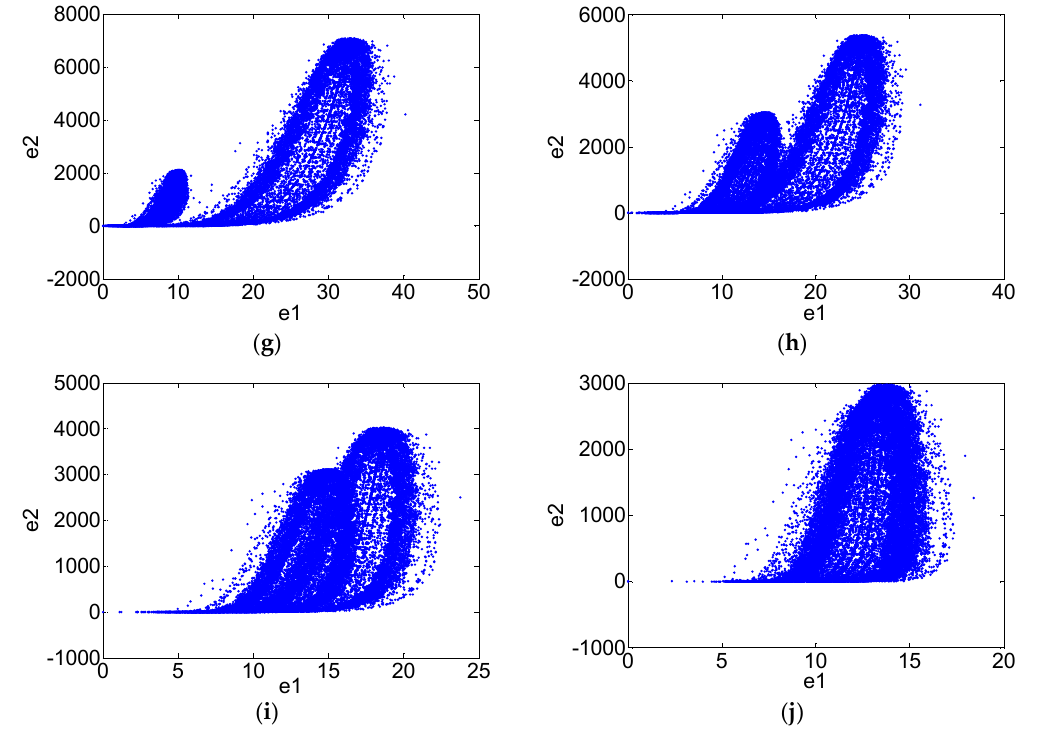
Figure 10. Chaotic dynamic error path showing islanding. ( a ) α = 1 ( b ) α = 0.9 ( c ) α = 0.8 ( d ) α = 0.7 ( e ) α = 0.6 ( f ) α = 0.5 ( g ) α = 0.4 ( h ) α = 0.3 ( i ) α = 0.2 ( j ) α = 0.1.